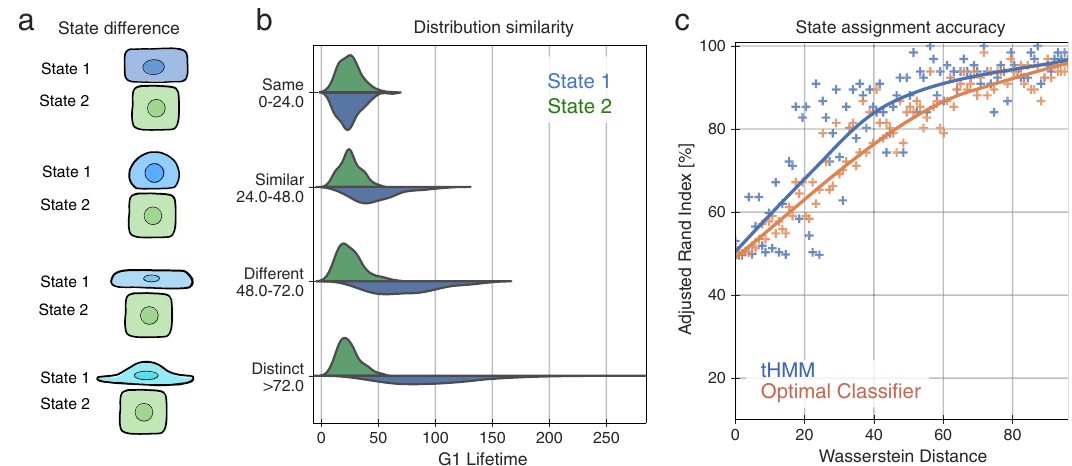
Fig. 5 Model performance versus the difference between states. a Cartoon of how two states can vary in their phenotypic similarity, in a synthetic population of two states. On the top, cells might be virtually indistinguishable (here based on shape). On the bottom, they might be so different that looking at one cell is suf fi cient to identify its state. b The distribution of G1 duration is varied in state 1 (blue) while the other state is kept constant. c State assignment accuracy versus the Wasserstein distance between state phenotypes. Each point represents the accuracy of state assignment for a lineage created by a set of parameters that yield the shown Wasserstein distance between the two-state distributions. 100 simulation trials are plotted. Either the tHMM model (blue) or an optimal classi fi er without lineage information (orange) was used. The solid lines show a Lowess trendline of the model accuracy.